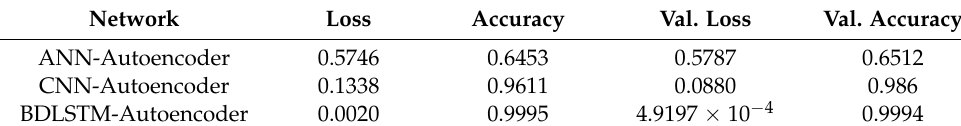
Table 6. Results of tests using the UNSW2018 dataset for three models.